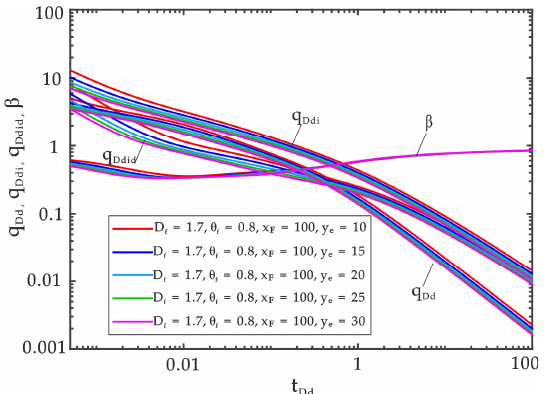
Figure 6. Blasingame curves considering the fractal characteristic of the fracture network.